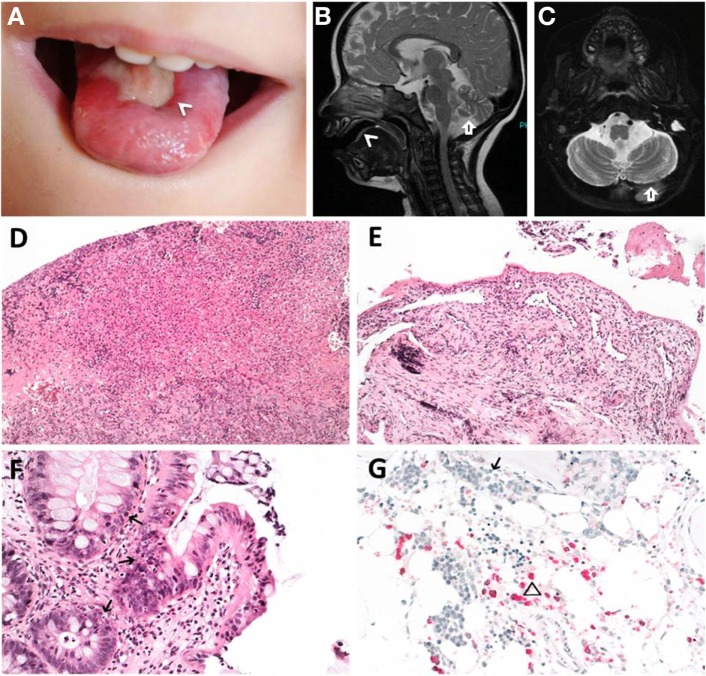
Clinical features of index patient 1 (P1). (A–C) Leukoplakia (<), sinistral cerebral hypoplasia (arrow). (D) Granulation tissue of tongue and (E) esophageal ulcers. (F) Apoptotic bodies in colon (arrows). (G) Hypocellular bone marrow before hematopoietic stem cell transplantation with immature erythropoiesis (arrow) and sparse myeloid precursors (triangle). (D–F) Hematoxylin and eosin staining, (G) naphthol-AS-d-chloroacetate esterase (NACE) staining.